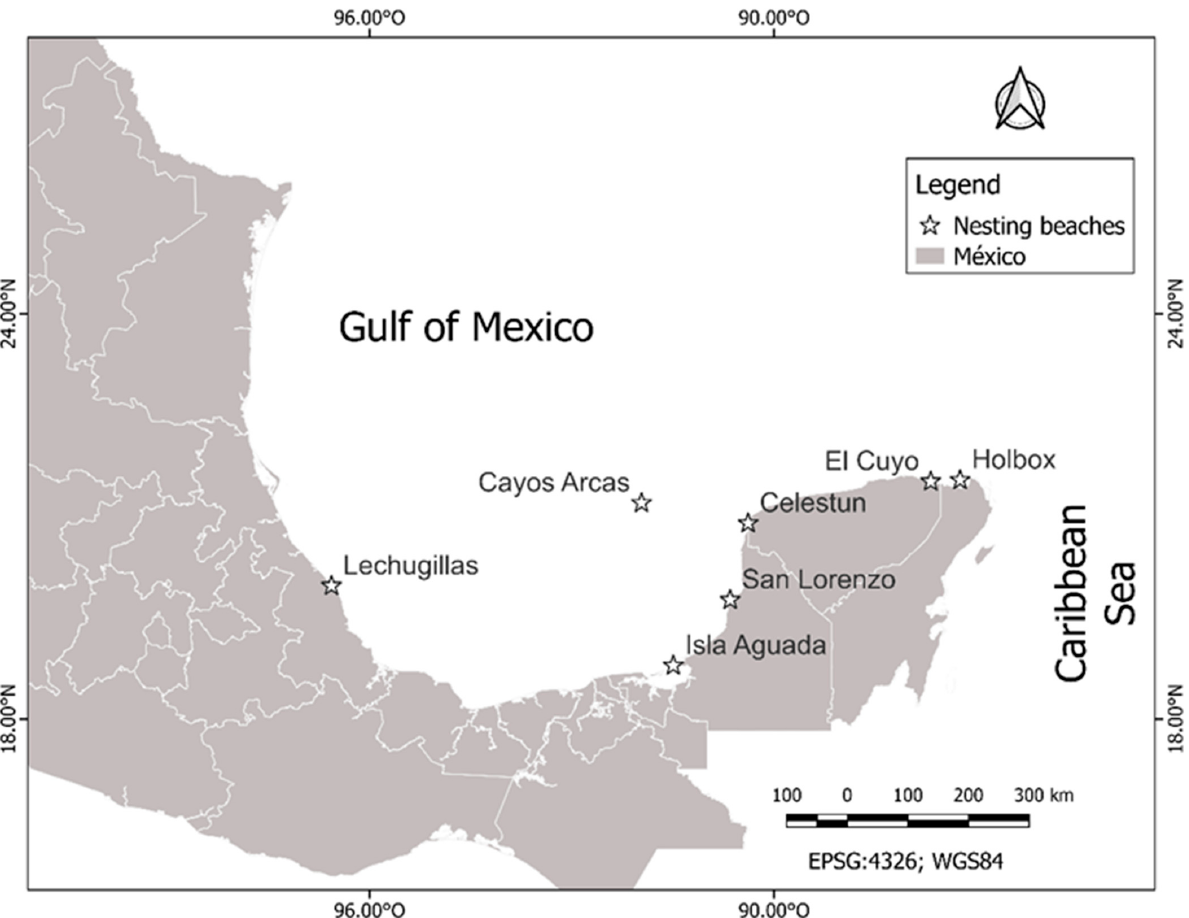
Figure 1. Location of the seven nesting beaches along the Gulf of Mexico coast where the study was conducted.